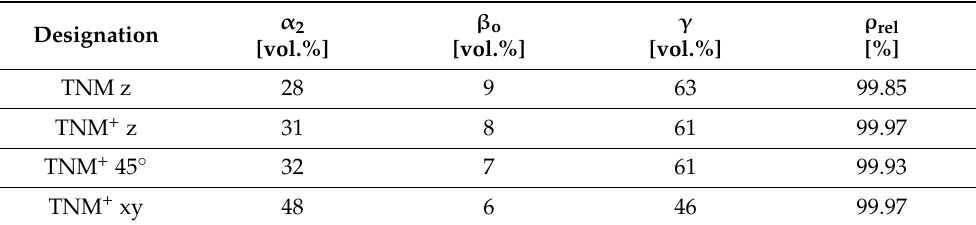
Table 2. Phase fractions established by XRD for the TNM and TNM + alloys and the relative density ρ rel in the as-built